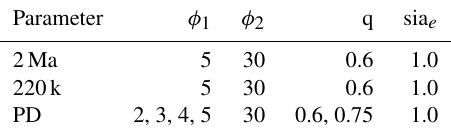
Table 2. Overview of parameters relevant for sliding in Sutter et al. (2019) (2Ma), for the 220kyr ensemble (220k) and for the present- day ensemble (PD); φ 1 is the minimum (for depths below − 700m) and φ 2 the maximum (for depths above 0m) till friction